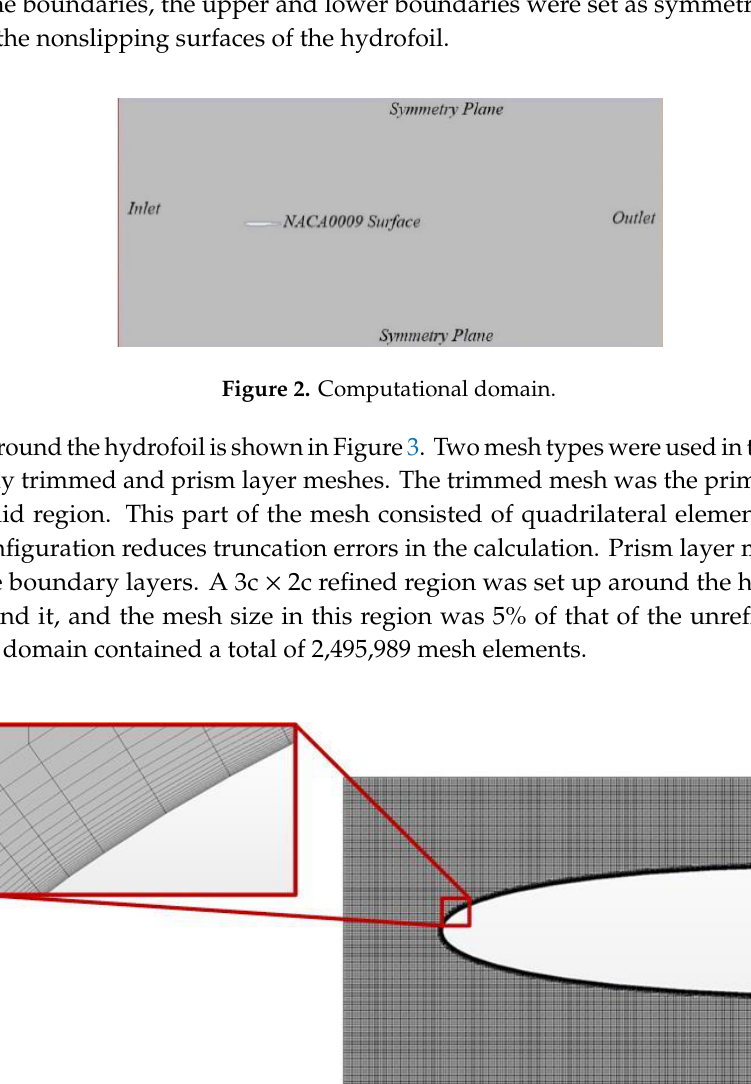
Figure 3. Computational domain mesh.